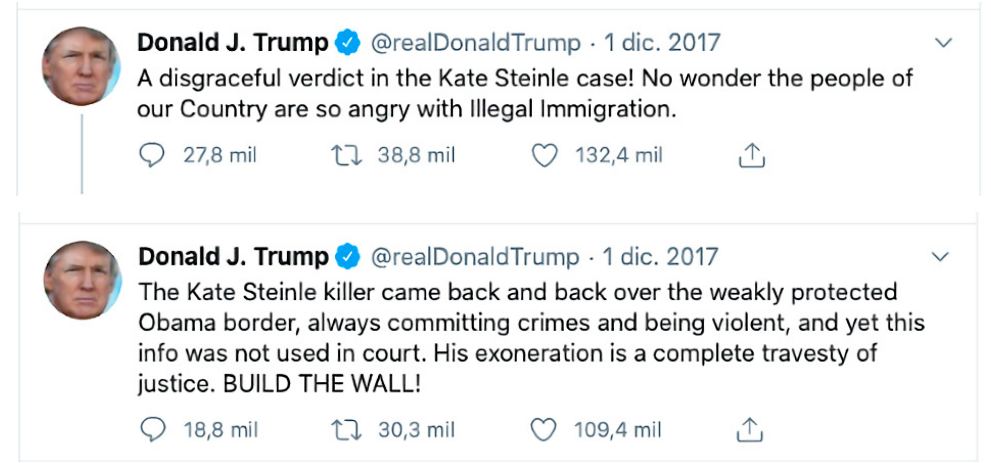
Figure 1. On the death of Kate Steinle.